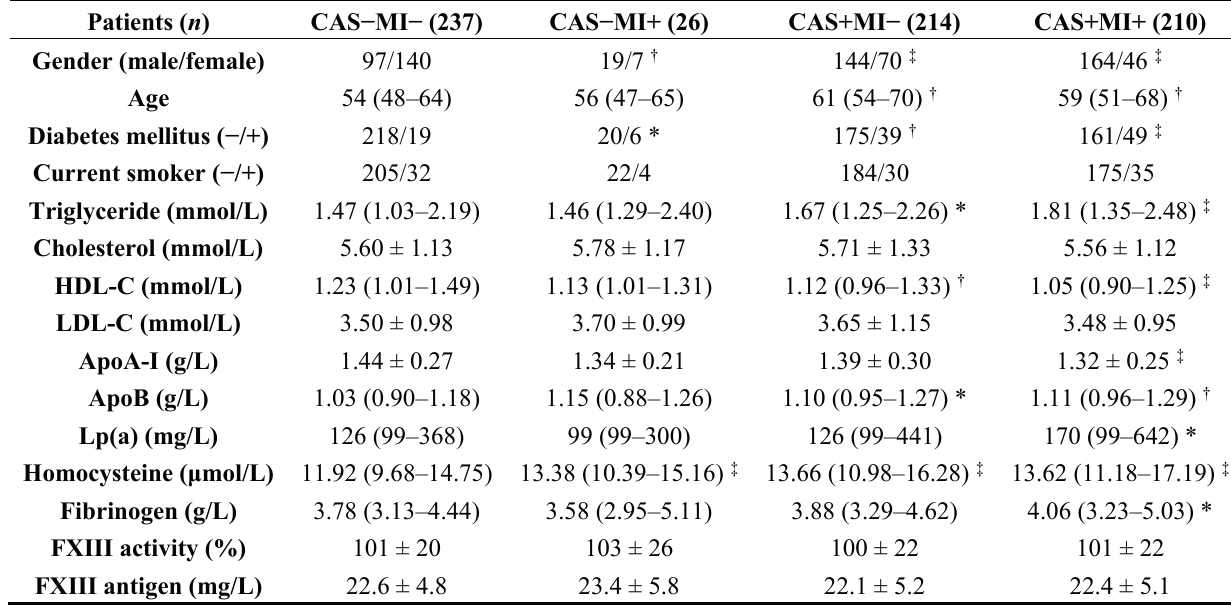
Table 1. General characteristics of the patient